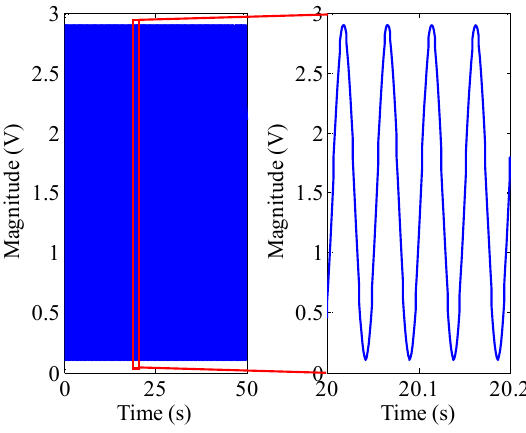
Figure 3. The time domain waveform of x ( t ) and its local enlarged drawing.